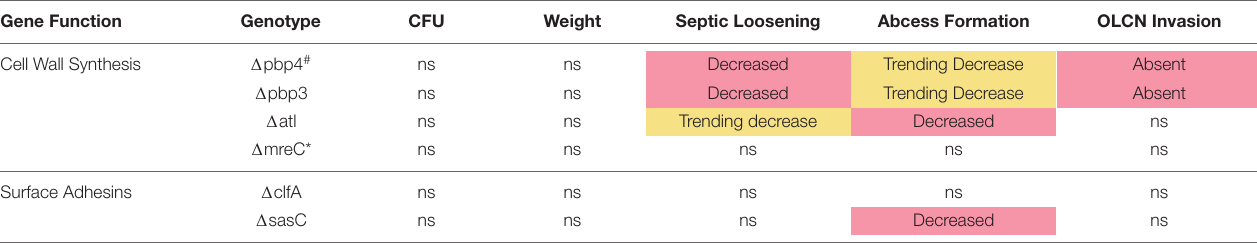
( Figure 7F ). Representative TRAP-stained histologic